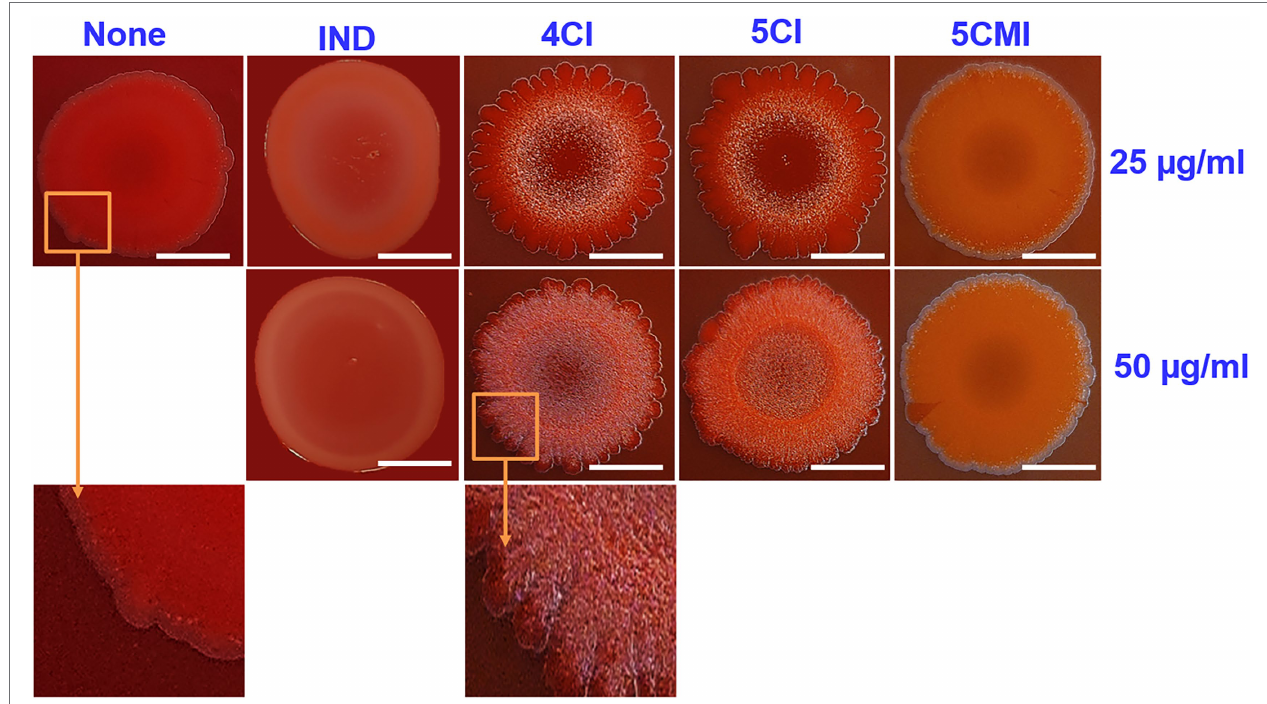
FIGURE 4 | Congo red curli assay of UPEC in the presence of indoles at concentrations of 25 and 50 μ g/ml. White scale bars represent 1 cm.